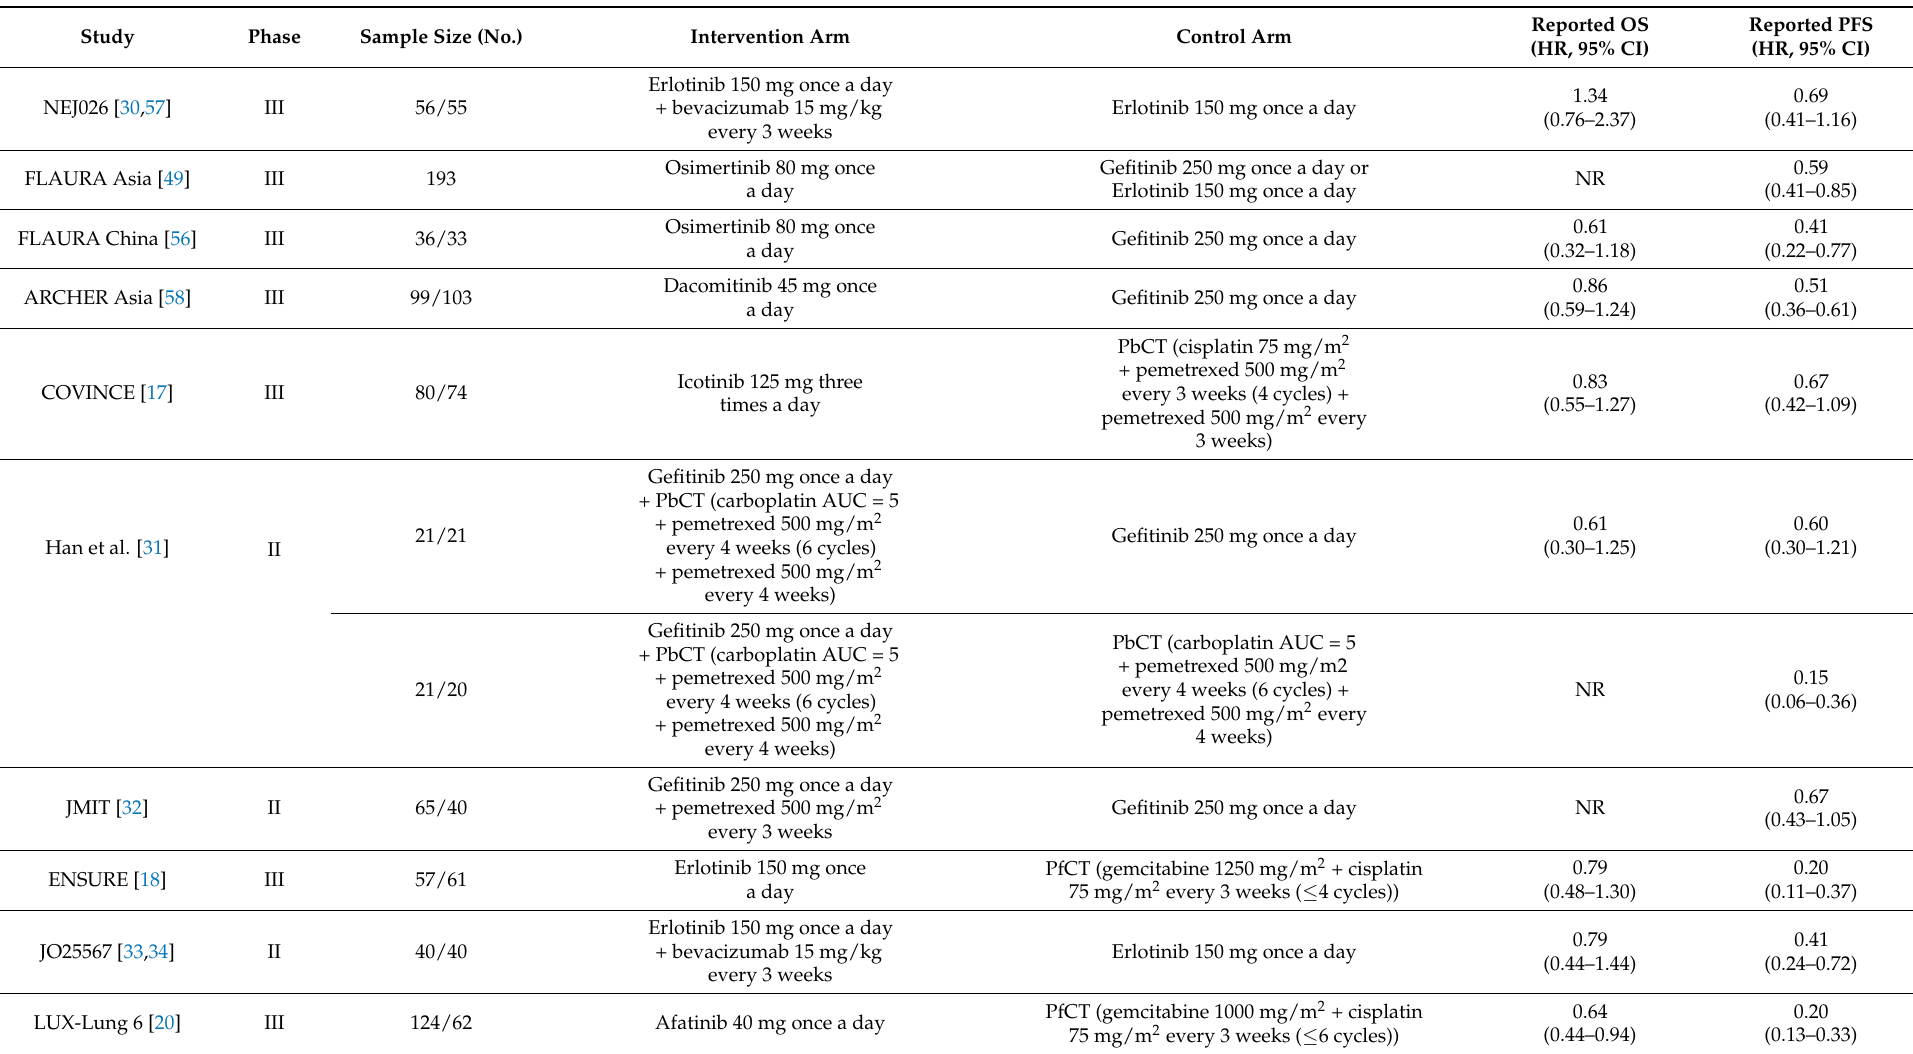
Table 1. Baseline characteristics of studies included in the network